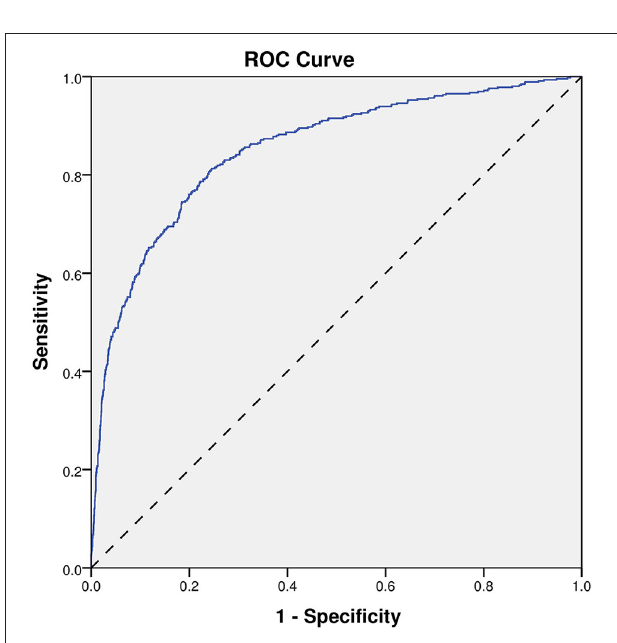
FIGURE 4 | ROC curve of the model. ROC, receiver-operating characteristic.